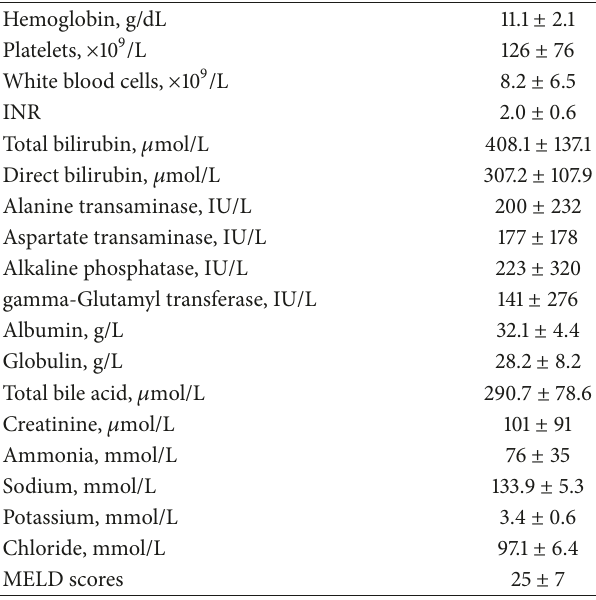
Table 1: Baseline laboratory parameters of patients before the first session of ALSS